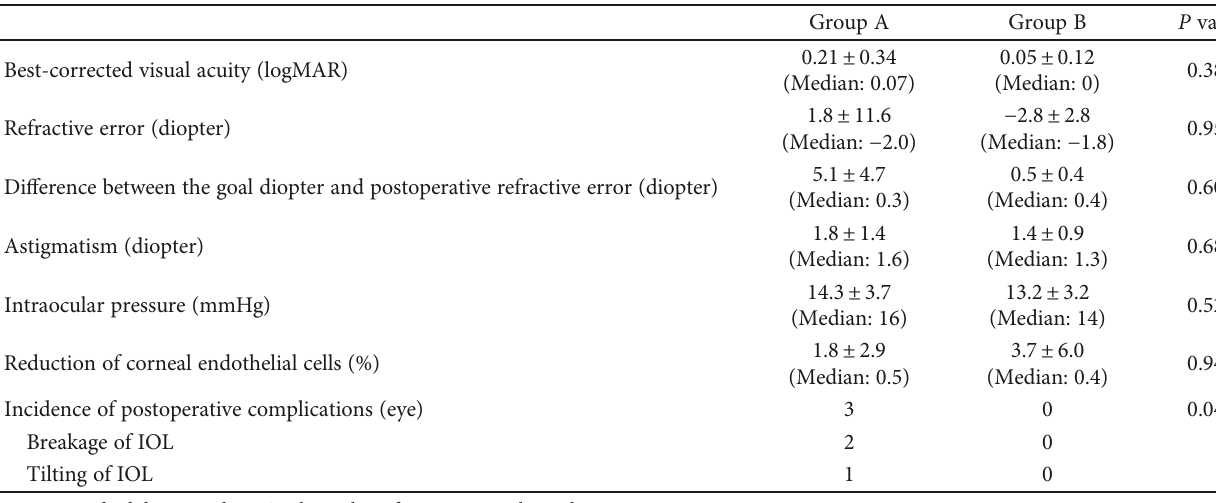
Table 2: Surgical outcome of the studied